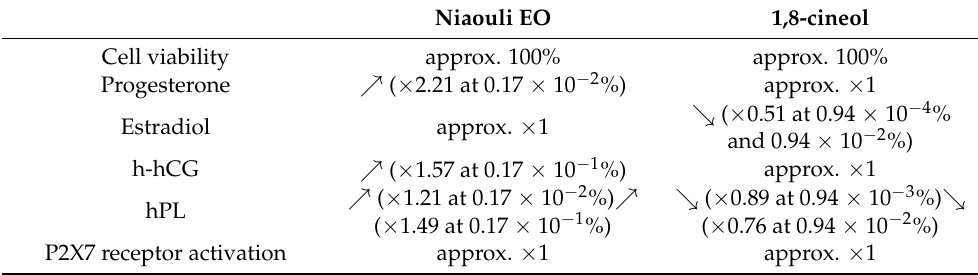
Table 2. Summary of the results of niaouli EO compared to 1,8-cineole. Niaouli EO 1,8-cineol Cell viability approx. 100% approx. 100% Progesterone (cid:37) ( × 2.21 at 0.17 × 10 − 2 %) approx. × 1 (cid:38) ( × 0.51 at 0.94 × 10 − 4 % Estradiol approx. × 1 and 0.94 × 10 − 2 %) h-hCG (cid:37) ( × 1.57 at 0.17 × 10 − 1 %) approx. × 1 (cid:37) ( × 1.21 at 0.17 × 10 − 2 %) (cid:37) (cid:38) ( × 0.89 at 0.94 × 10 − 3 %) (cid:38) hPL ( × 1.49 at 0.17 × 10 − 1 %) ( × 0.76 at 0.94 × 10 − 2 %) P2X7 receptor activation approx. × 1 approx. ×